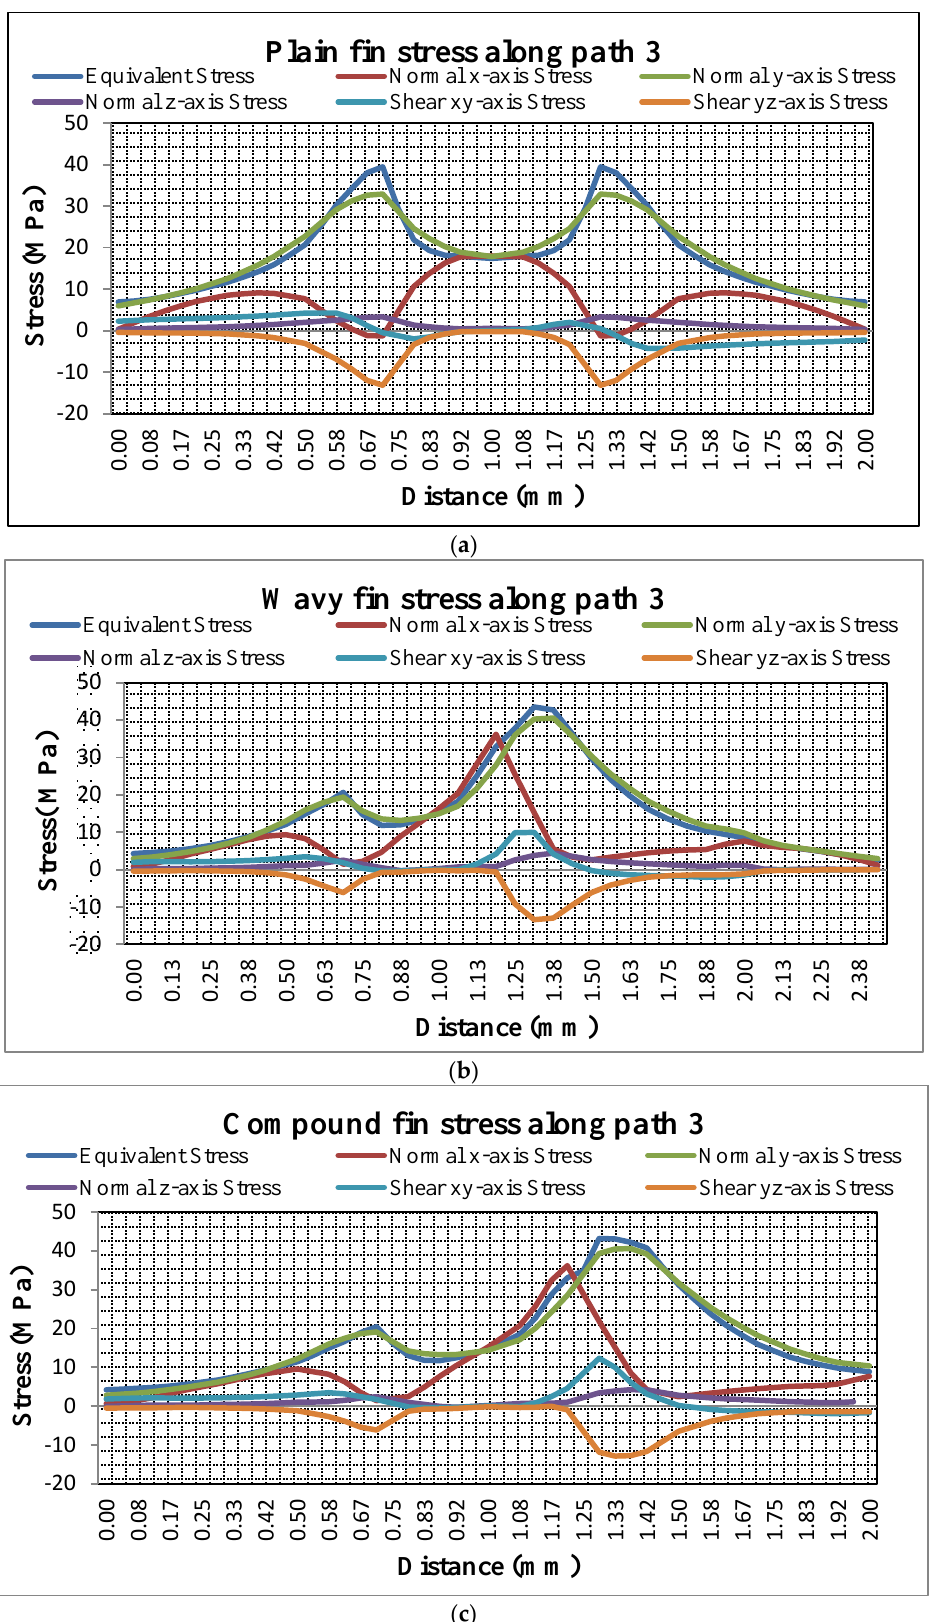
Figure 10. Stresses along path 3 of brazed seam in plain, wavy and compound fins. ( a ) Stresses for plain fin. ( b ) Stresses for wavy fin. ( c ) Stresses for compound fin.